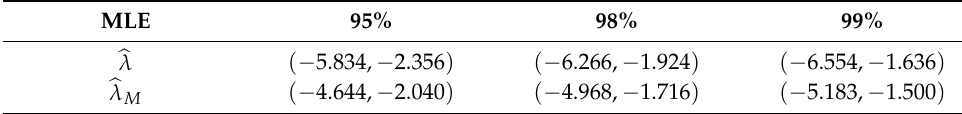
Table 6. Confidence intervals for the estimated values of (cid:98) λ and (cid:98) λ M .